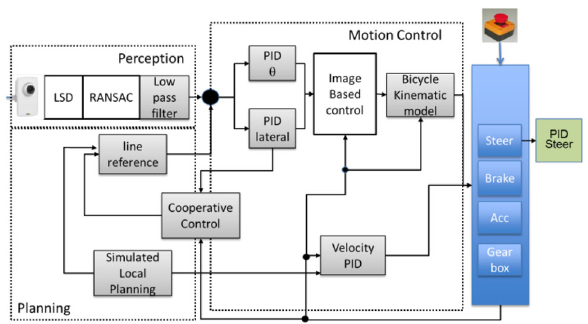
Fig. 6 Block diagram of the cooperative trajectory control based on